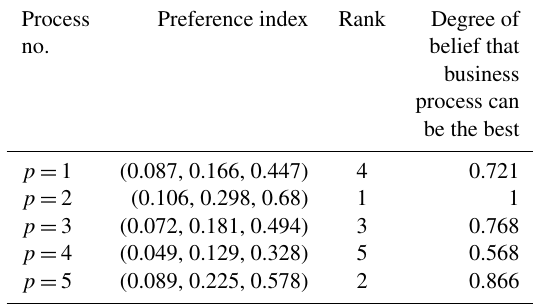
Table 6. Preference indices of business processes and their rank under safety performance.